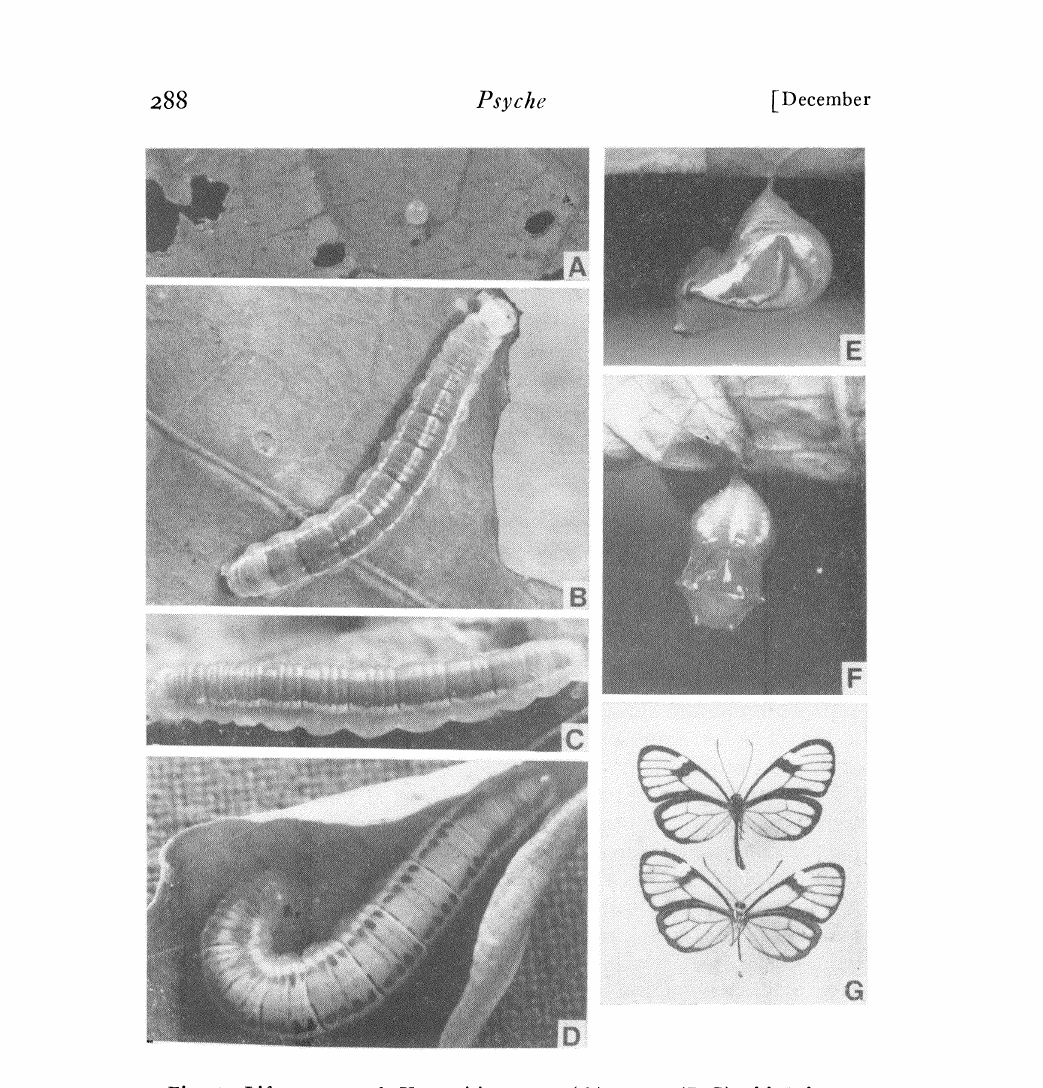
Fig. 2. Life stages of Hymenitis nero. (A) egg; (B-C) third instar; (D) fourth instar (E-F) pupa (G) adult